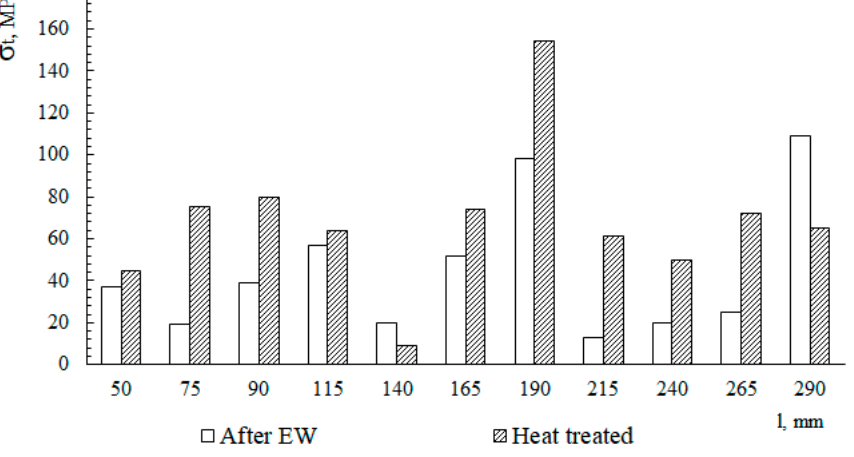
Figure 13. The tear strength values distribution along the bimetal sheet.